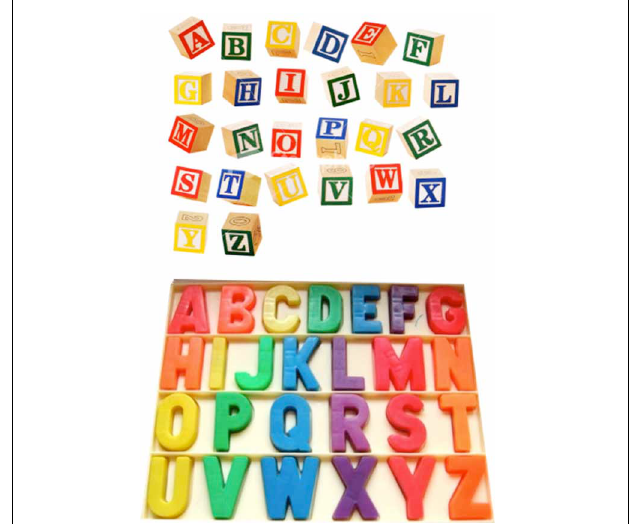
FIGURE 1 | Letter-color associations may have been acquired early on in development through common associations between letters and colors, as illustrated in these